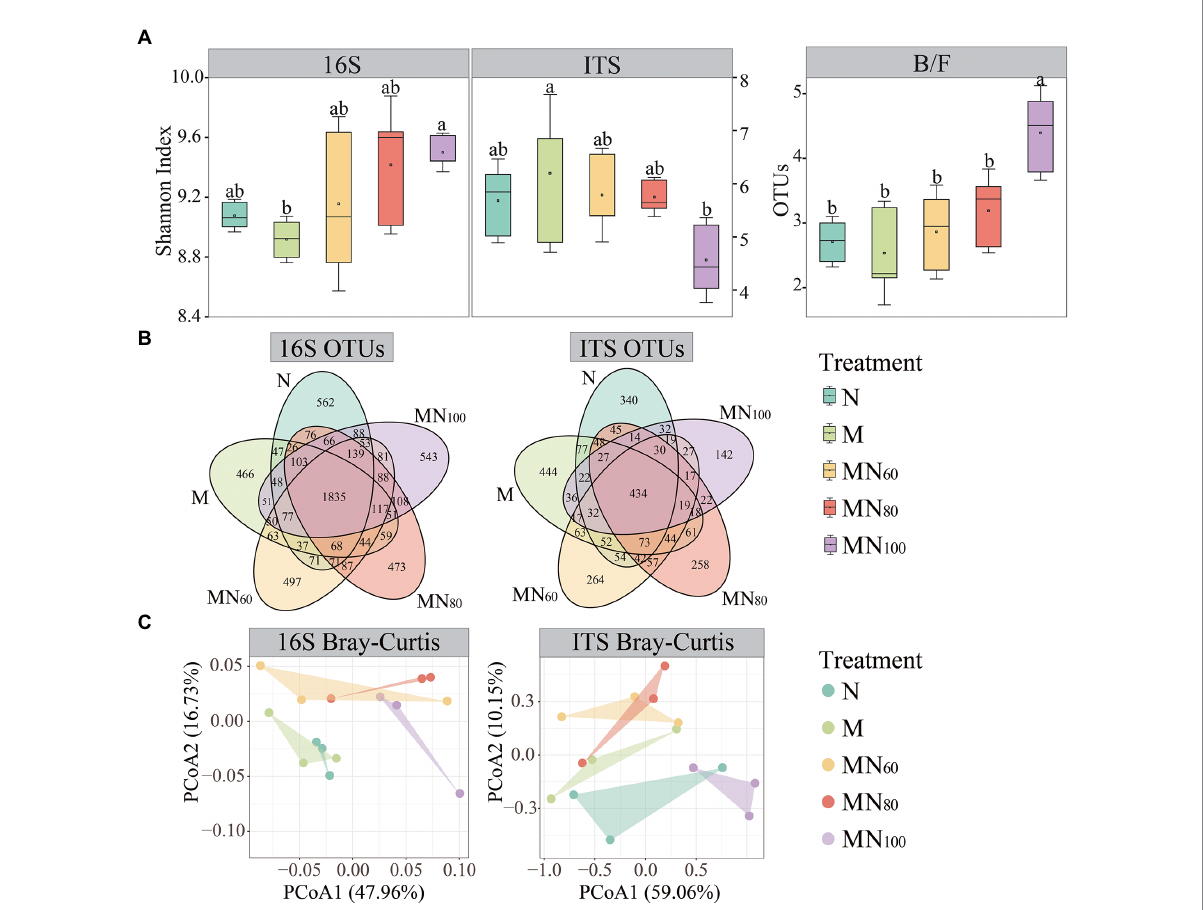
FIGURE 2 Soil microbial communities under different fertilizer treatments. (A) Shannon index of soil bacterial and fungal species as influenced by fertilizer treatments. Significant effects were obtained by one-way ANOVA test. Different lowercase letters indicate significant differences of bacteria and fungi among treatments, respectively ( p < 0.05). (B) Venn diagram of bacterial and fungal richness in different fertilization treatments. (C) Principal coordinate analysis (PCoA) plot of microbial community structures based on Bray–Curtis between samples of different fertilization